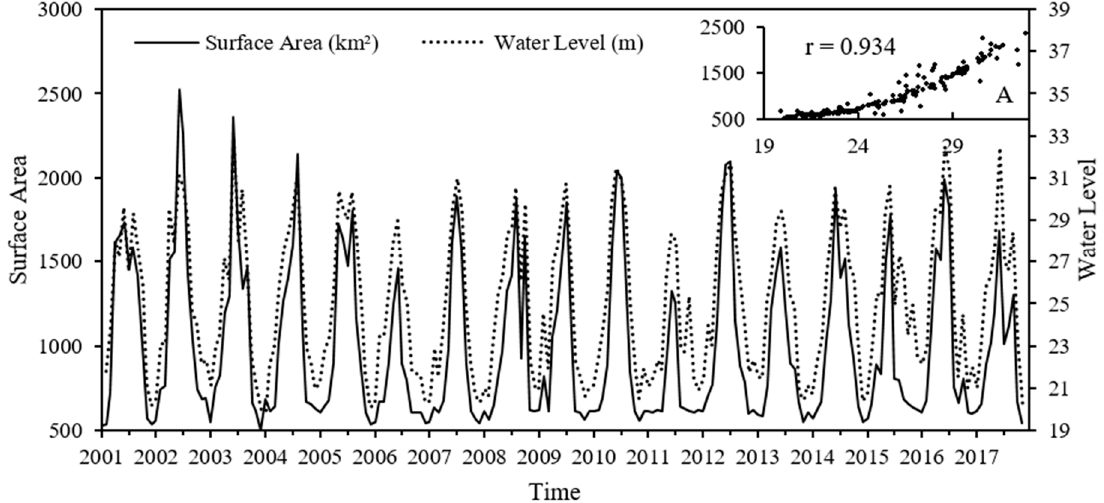
Figure 4. Relationship between the lake water area and water level. A is a scatter plot of the correlations.